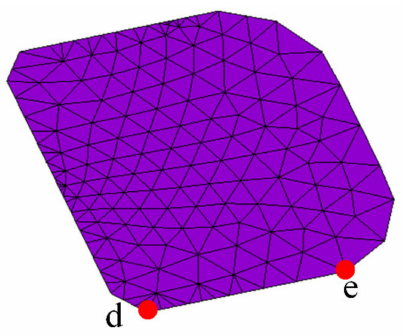
Figure 12. Points d and e are the location of the critical point.